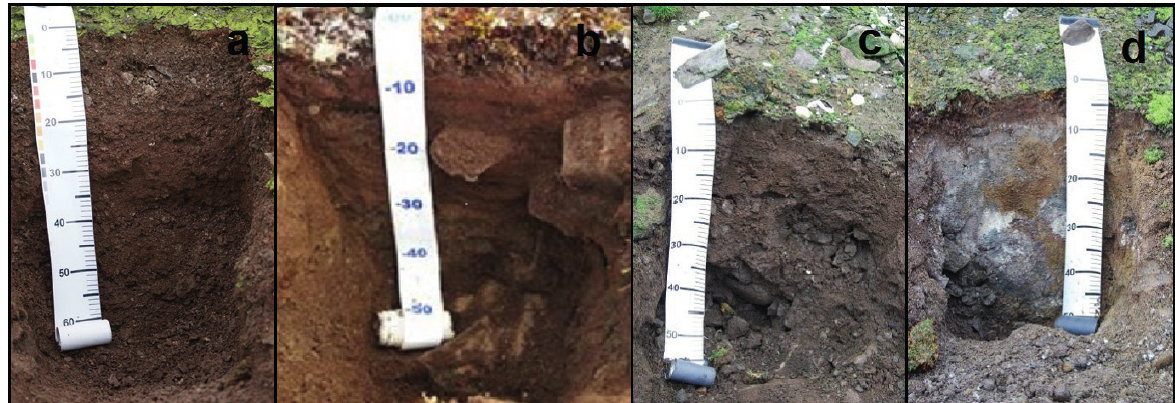
Figure 2. Representative pedons of soils infl uenced by gentoo penguins (P1 and P2) in the Livingston Island, and by kelp gulls (P3) and giant petrels (P4) in the Nelson Island, Antarctica. a) P1 - Haplic Leptsol (Ornithic, Skeletic); b) P2 - Haplic Leptosol (Ornithic, Humic); c) P3 - Lithic Skeletic Leptsol (Ornithic, Novic); d) P4 - Leptic Cambisol (Ornithic,